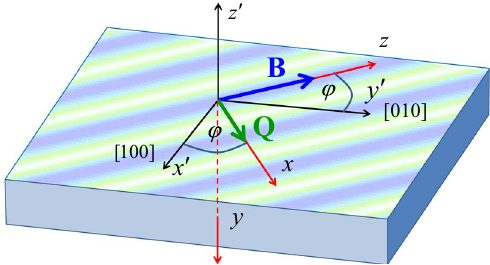
Figure 1. Reference frames  ′ (black) and  (red) for the electronic states in a 2DEG with SOC and in-plane magnetic field B . The striped pattern along the ϕ = 45° direction indicates the persistent spin helix state of the 2DEG, with wave vector Q , which forms in the absence of B if the Rashba and Dresselhaus coupling strengths are